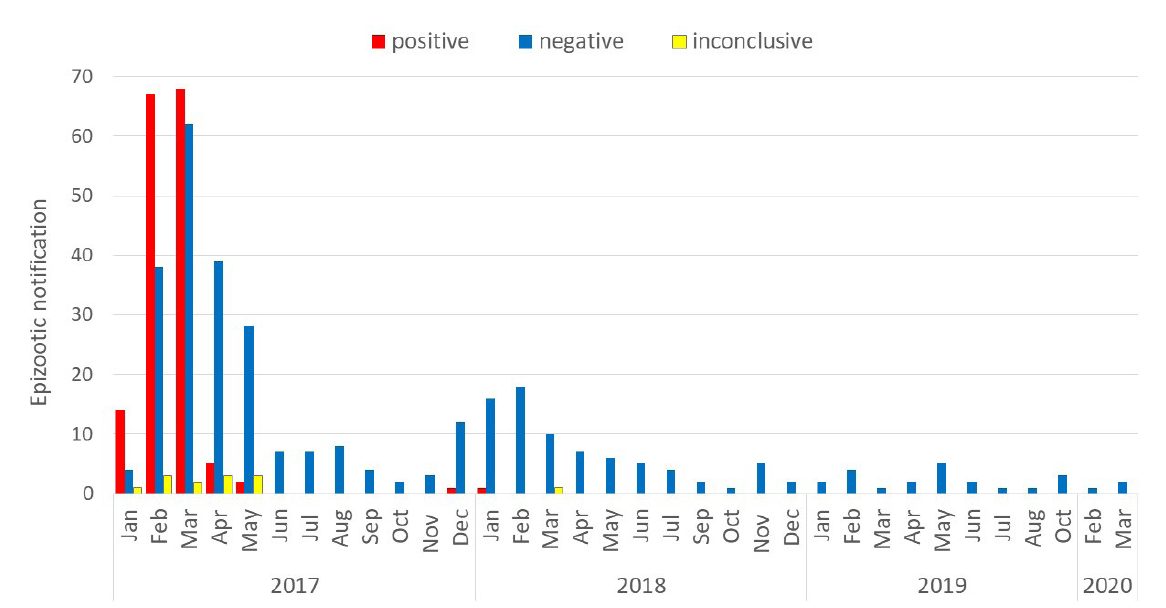
Figure 1. Temporal distribution of epizootics, recorded in the state of Espírito Santo from 2017 to